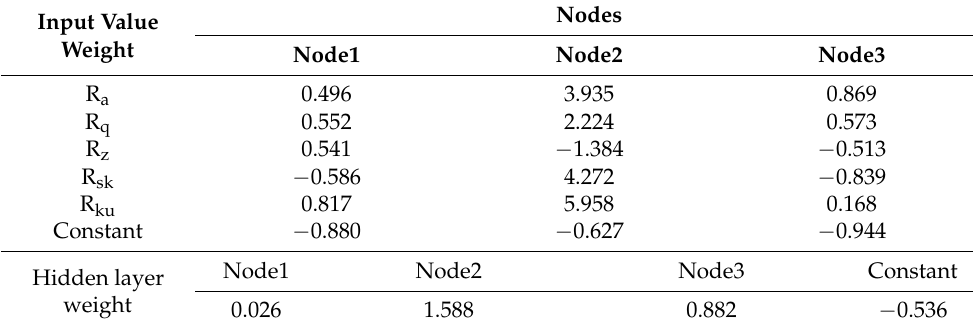
Table 9. Calculated model weights with F 20 as the output